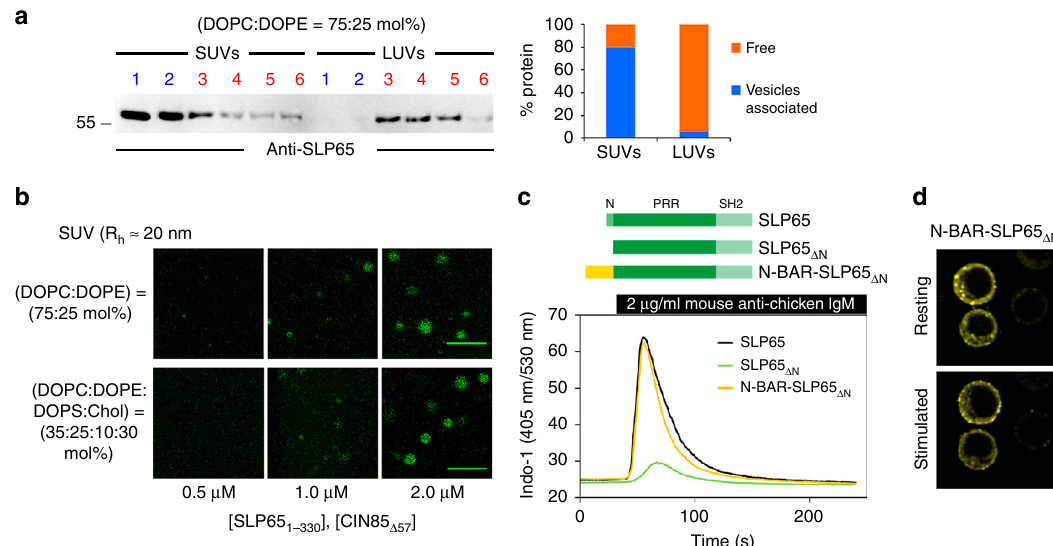
Fig. 2 Phase separation modulated by vesicle curvature and lipid composition. a A mixture of recombinant SLP65 with either SUVs (Rh ≈ 20 nm) or LUVs (Rh ≈ 60 nm) was fractionated by a sucrose gradient fl otation assay, and the different layers were subjected to anti-SLP65 immunoblot analysis (apparent MW indicated in kDa). Vesicles will fl oat to the top and are found in layers 1 and 2. Bar graph shows the percentage of SLP65 associated with vesicles based on the immunoblot signal intensity. b Confocal fl uorescence microscopy of a mixture of different concentrations of Atto 430LS-tagged SLP65 1-330 and CIN85 Δ 57 together with SUVs containing DOPC:DOPE of 75:25 mol% ( b , top) and DOPC:DOPE:DOPS:cholesterol of 35:25:10:30 mol% ( b , bottom), respectively. (Scale bar = 10 μ m) Source data are provided as a Source Data fi le. c SLP65-de fi cient DT40 B cells were transduced with constructs encoding citrine-tagged SLP65 Δ N fusion proteins with the N-BAR domain of Amphiphysin. Wild-type SLP65 and SLP65 Δ N -expressing cells served as positive and negative controls, respectively. The domain structures of the expressed SLP65 variants are depicted in the upper part of ( c ). Cells were loaded with the Ca 2 + -sensitive fl uorophore Indo-1 and Ca 2 + fl ux was monitored by fl ow cytometry. Cells were stimulated with anti-BCR antibody (M4) at the indicated time point. d Confocal fl uorescence microscopy of cells transduced with N-BAR-SLP65 Δ N were either left untreated (upper panel) or stimulated via their BCR (lower